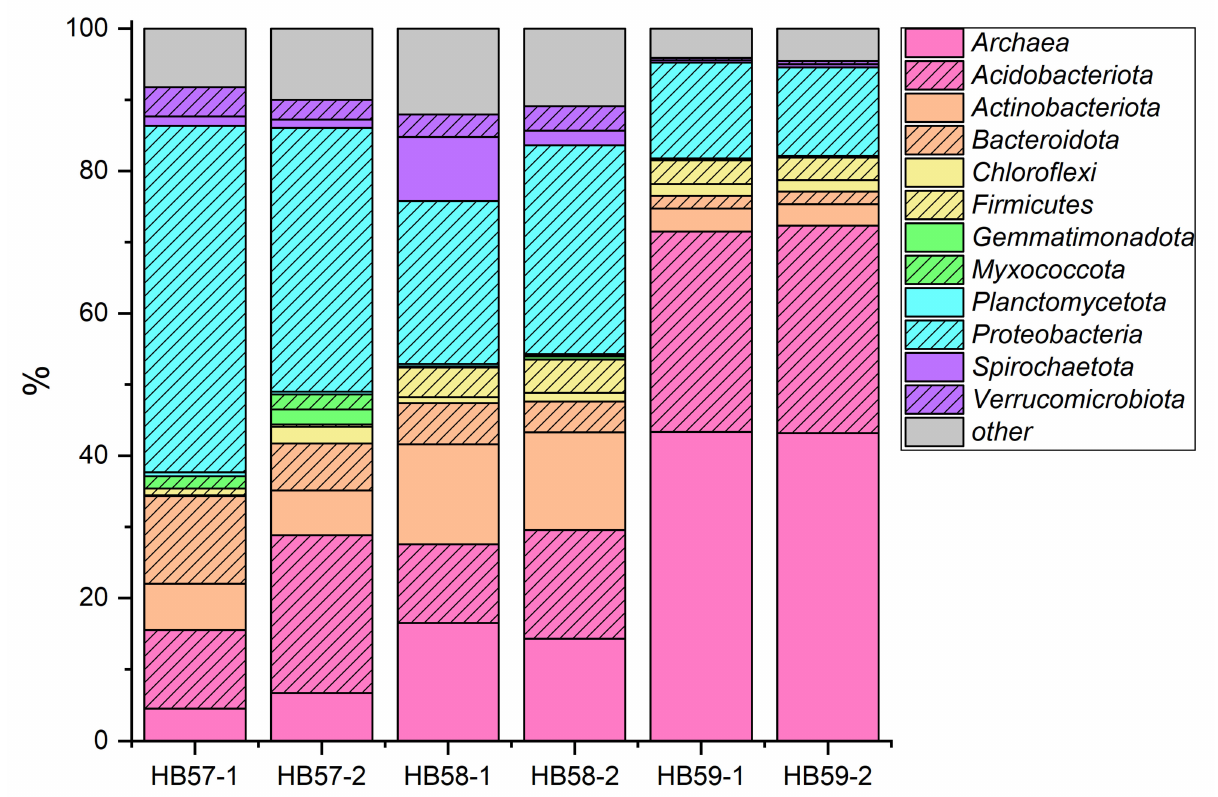
Figure 2. Stacked column plot of percentage distribution of the soil microbiome at phylum level. Each sample, including duplicate sample locations, is shown in a separate column. The 12 most dominant phyla are named. Low-abundance representatives are summarized in